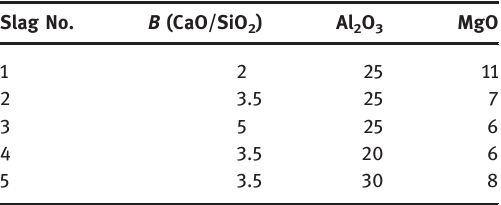
Table 1: Original chemical composition of slags, mass%.